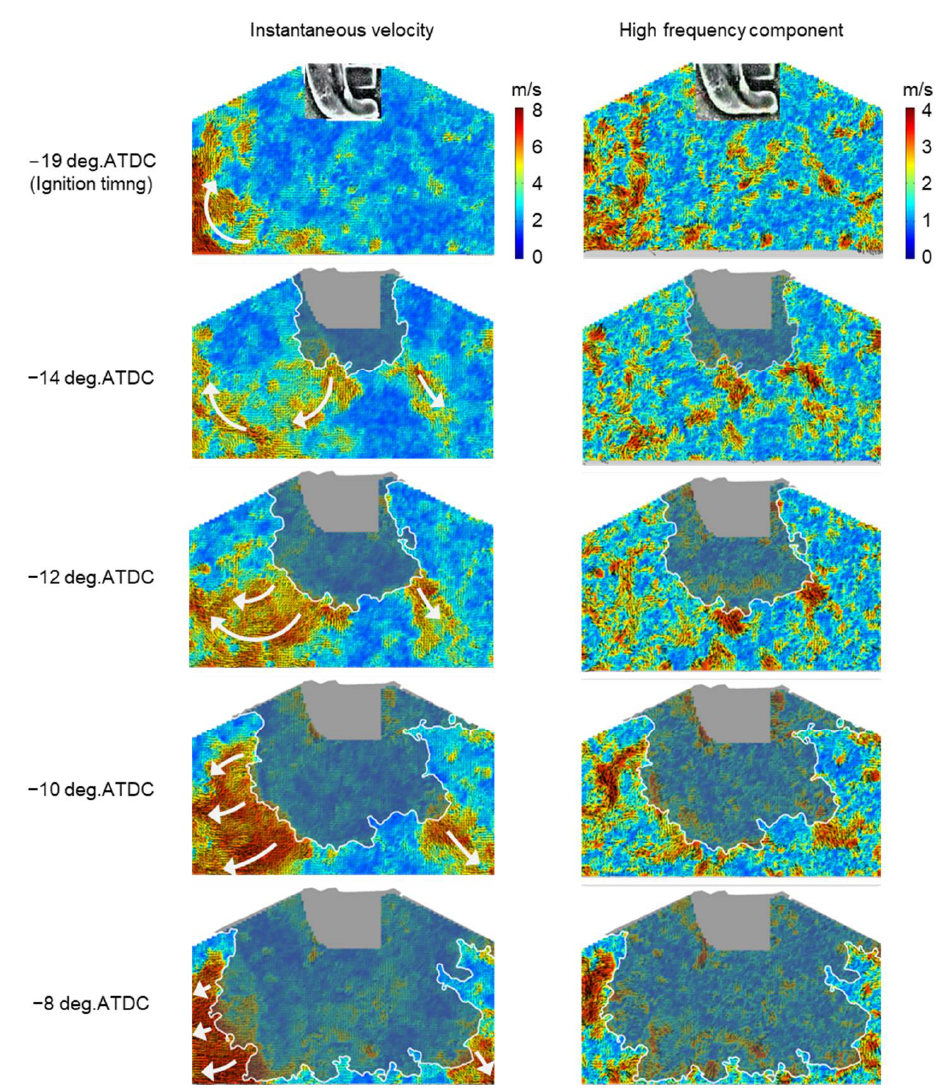
Figure 11. Initial flame propagation and instantaneous velocity and turbulent field in cycle A (Engine speed: 1200 rpm, intake pressure: 60 kPa, equivalence ratio.